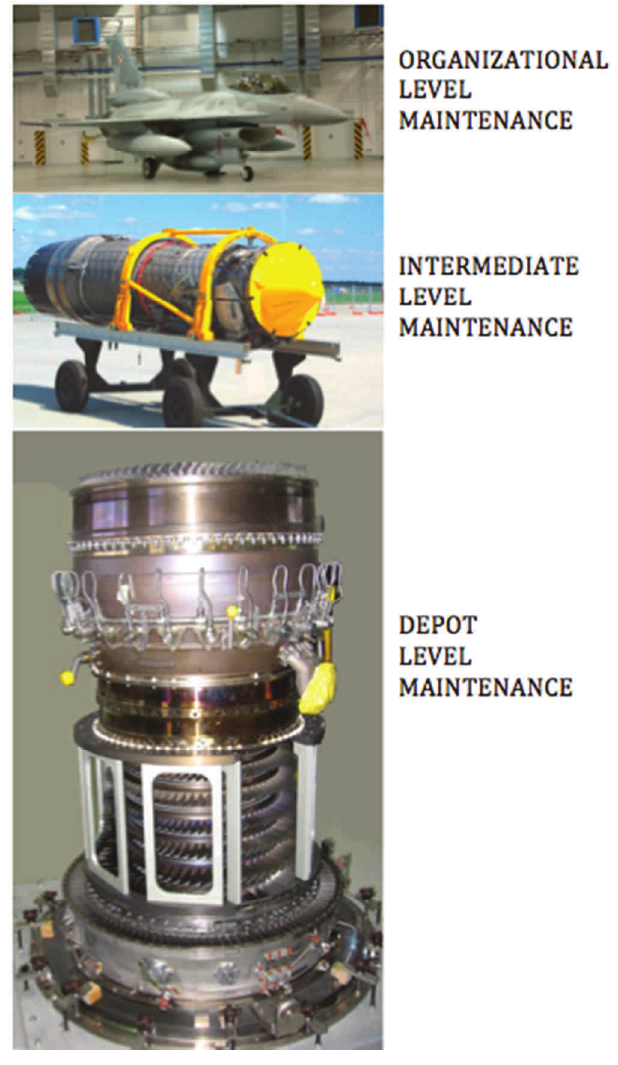
Fig. 3. Levels of